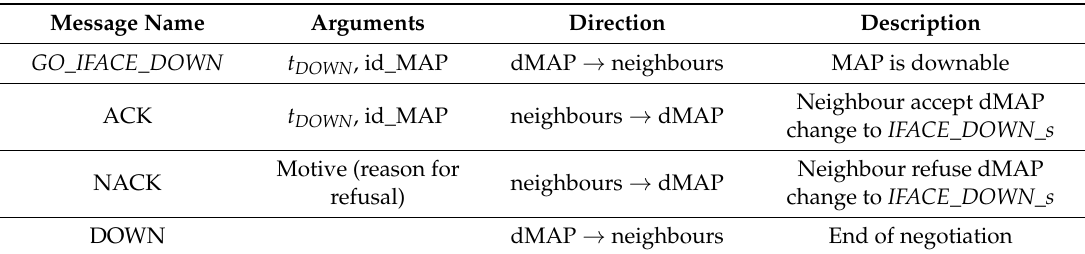
Table 3. List of messages the MAPs manage to set its wireless interface orderly down.